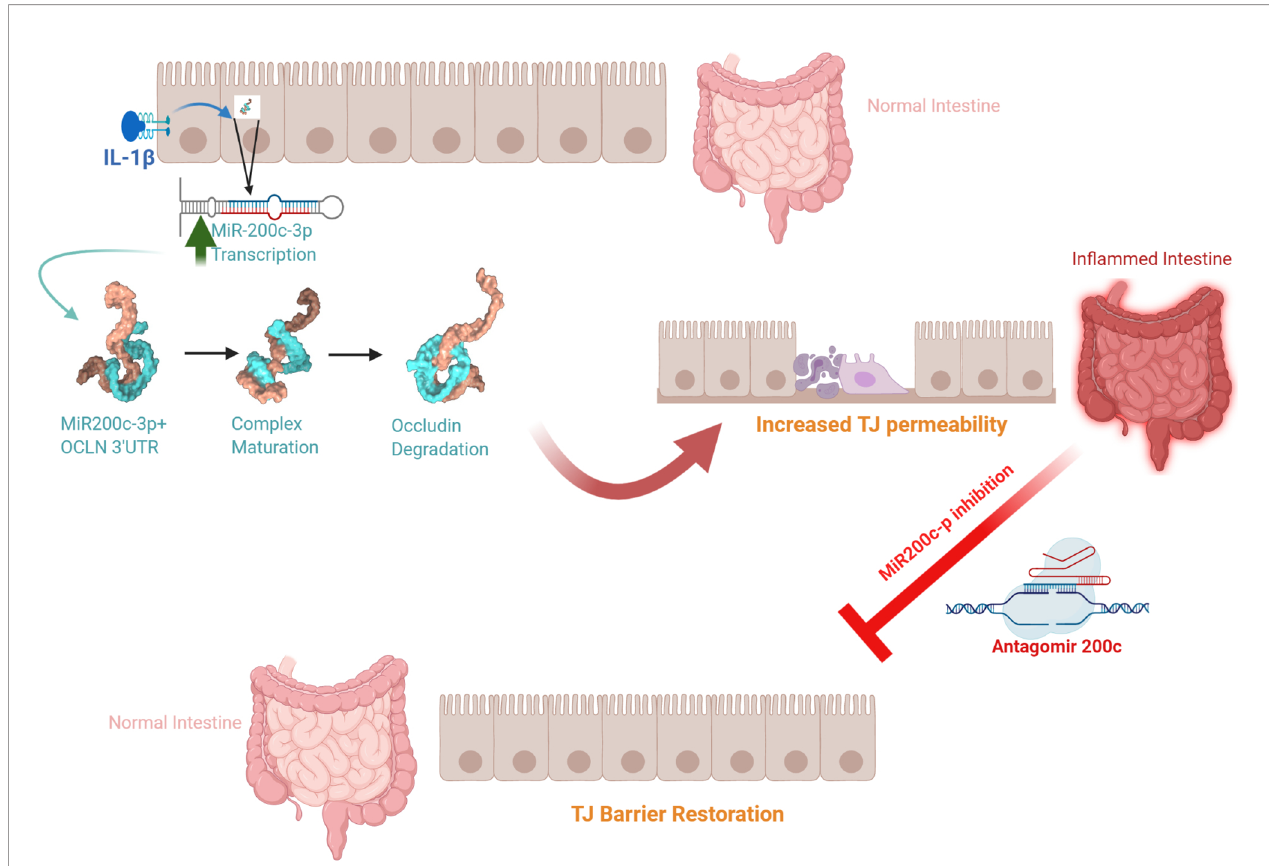
FIGURE 3 | Schematic diagram of the potential role of the interleukin-1 b (IL-1 b )-induced increase in microRNA-200c-3p expression and intestinal tight junction (TJ) permeability in modulating intestinal in fl ammation. (Created with